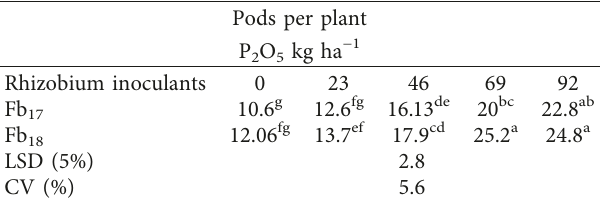
Table 10: Interaction effects of rhizobium inoculation and P fertilizer rate on pods per plant.